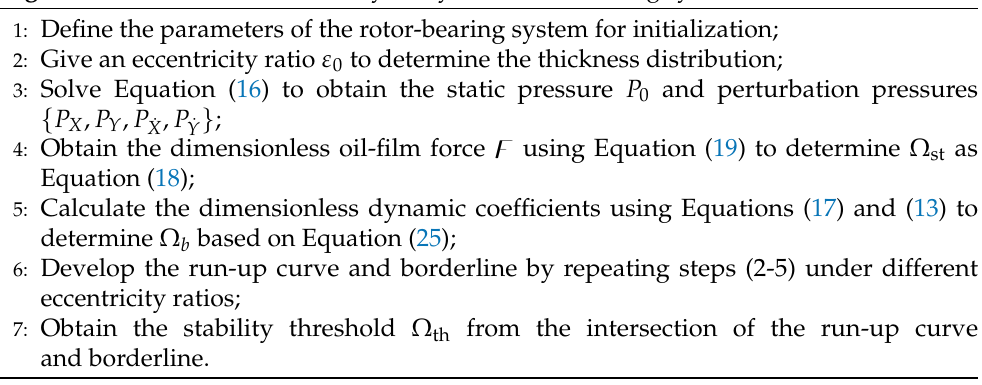
Algorithm 1 Deterministic stability analysis of rotor-bearing